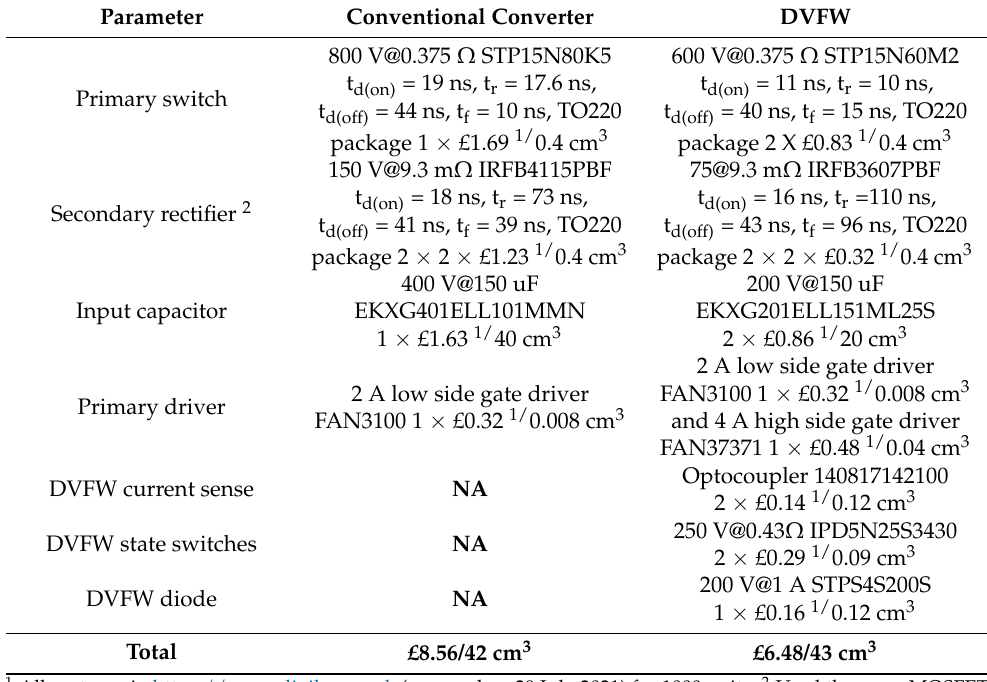
Table 3. Price/size comparison between conventional forward converter and